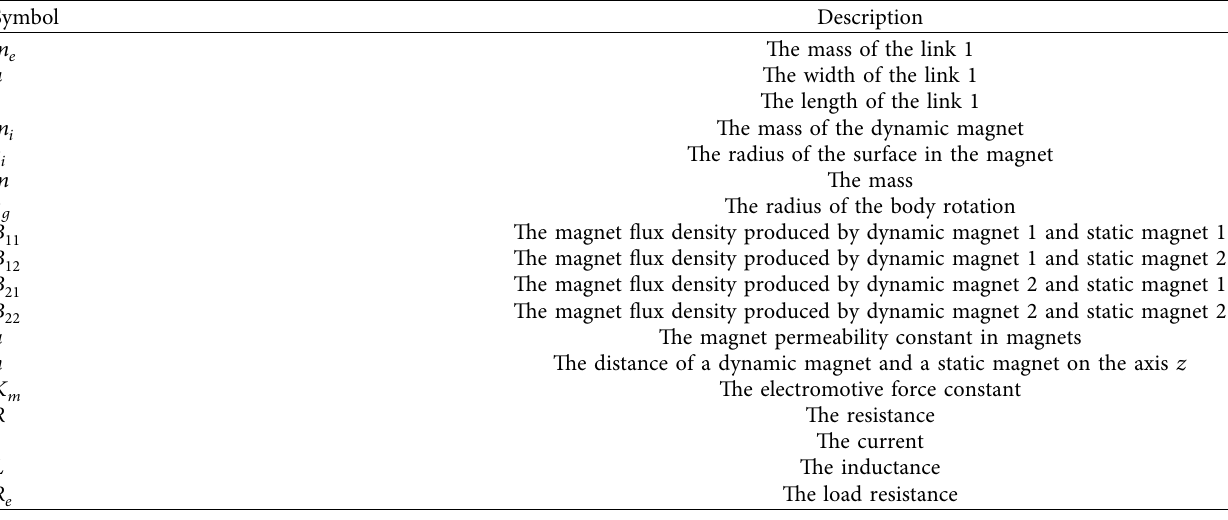
Table 1: Description of the electricity generator